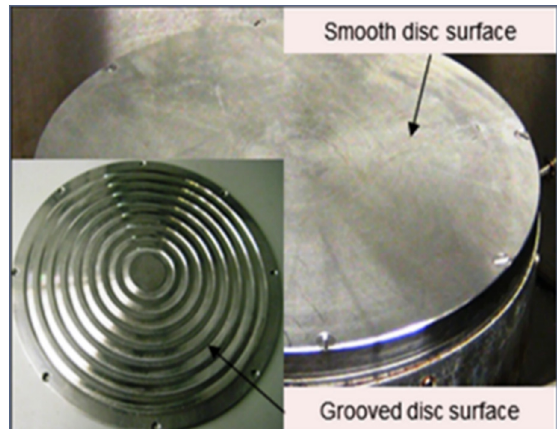
Figure 2. Grooved and smooth disc surfaces. Reproduced from [14] , De Gruyter, 2019.